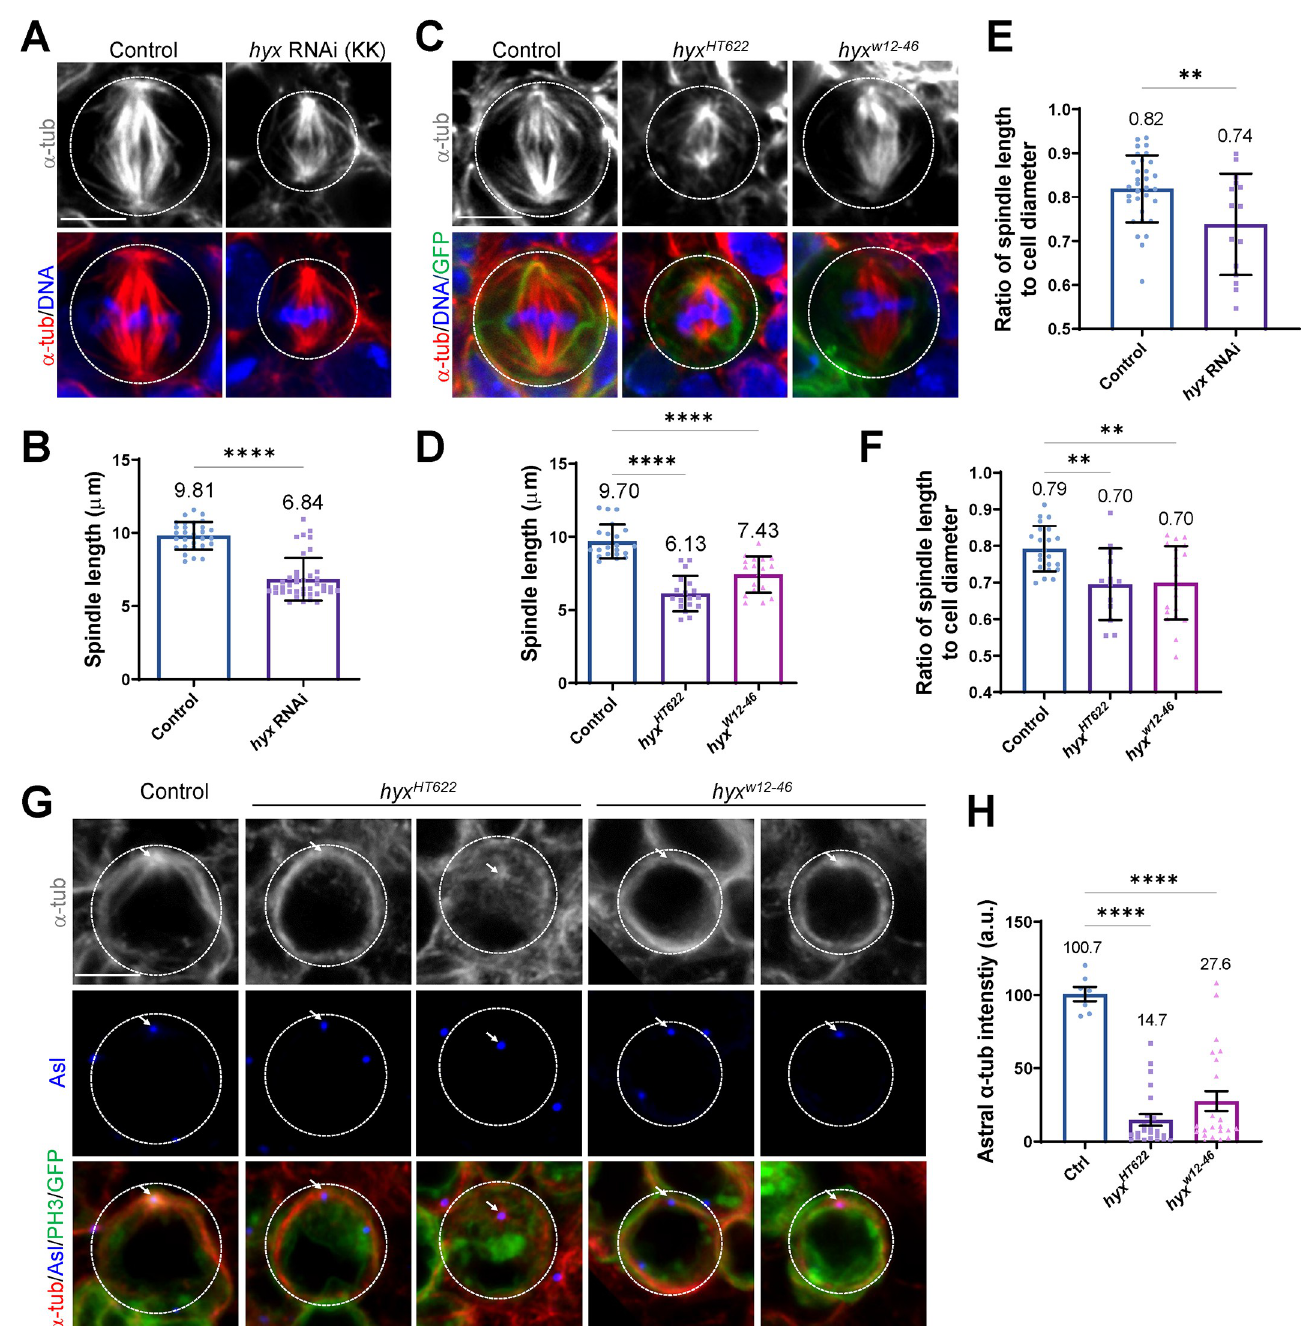
Fig 3. Hyx is required for the formation of the microtubule aster and the mitotic spindle in NSCs. ( A ) Metaphase NSCs of control ( UAS- β -Gal RNAi) and hyx RNAi (KK/V103555) under the control of insc -Gal4 were labelled for α -tub and DNA. ( B ) Quantification of spindle length (with SD) observed in A. Spindle length: control, 9.81 ± 0.94 μ m, n = 29; hyx RNAi, 6.84 ± 1.46 μ m, n = 40. ( C ) NSCs of control (FRT82B), hyx HT622 , and hyx W12-46 MARCM clones were labelled for α -tub and DNA and CD8-GFP. ( D ) Quantification of spindle length (with SD) observed in C. Spindle length: control, 9.70 ± 1.15 μ m, n = 21; hyx HT622 , 6.13 ± 1.22 μ m, n = 18; hyx W12-46 , 7.43 ± 1.25 μ m, n = 18. ( E ) Ratio of spindle length to NSC diameter (with SD) for genotypes in A. Control: 0.82 ± 0.08, n = 32; hyx RNAi, 0.74 ± 0.12, n = 15. ( F ) Ratio of spindle length to NSC diameter (with SD) for genotypes in B. Control: 0.79 ± 0.06, n = 22; hyx HT622 , 0.70 ± 0.10, n = 13; hyx W12-46 , 0.70 ± 0.10, n = 21. ( G ) Interphase NSCs from control (FRT82B; n = 11), hyx HT622 ( n = 24), and hyx w12-46 ( n = 29) MARCM clones were labelled for α - tub, Asl, GFP, and PH3. NSCs failed to form a microtubule aster in 79.2% of hyx HT622 and 34.5% of hyx w12-46 clones. The rest of them formed weak microtubule asters. ( H ) The immunofluorescence intensity of astral microtubule (with SEM) labelled by α -tub for genotypes in G. Control: 100.7 ± 12.77, n = 7; hyx HT622 , 14. 7 ± 19.12, n = 23; hyx W12-46 , 27.6 ± 32.56, n = 23. Cell outlines are indicated by white dotted lines. Arrows indicate the centrosomes. Statistical significances were determined by unpaired two-tailed Student t test in B. One-way ANOVA with multiple comparison were performed in D, F, and H. ���� p < 0.0001 for B, D, F; �� p = 0.0065 for E; In F, �� p = 0.0045 for hyx HT622 and �� p = 0.0017 for hyx W12-46 . Scale bars: 5 μ m. The underlying data for this figure can be found in the S1 Data. Asl, Asterless; α -tub, α -tubulin; Hyx, Hyrax; MARCM, mosaic analysis with a repressible cell marker; NSC, neural stem cell; RNAi, RNA interference.